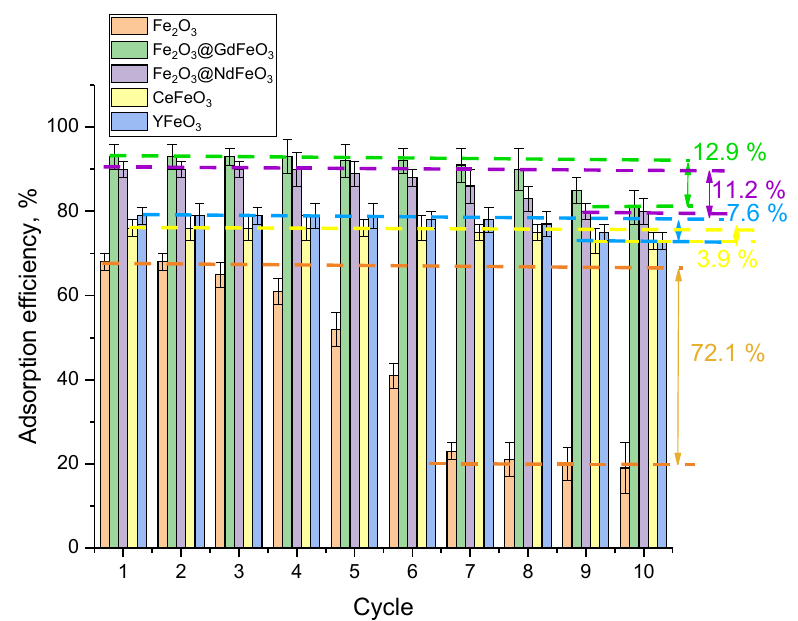
Figure 9. Evaluation results of changes in adsorption efficiency as a result of cyclic tests with repeated use of nanoparticles.